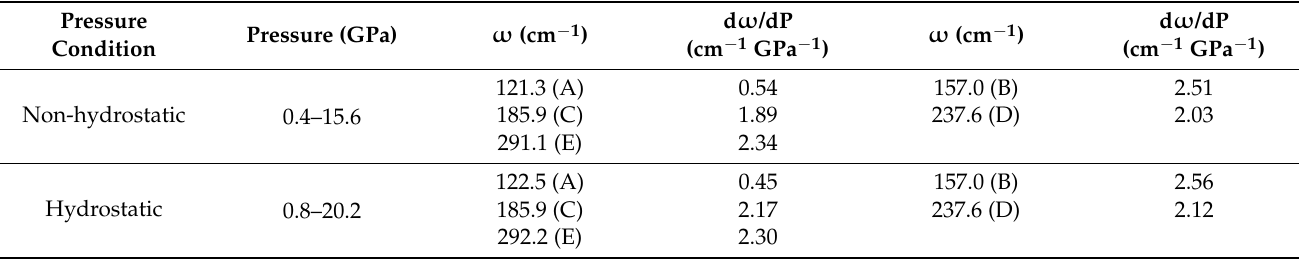
Figure 3. Pressure dependence of the Raman full width at half maximum (FWHMs) for Ga 2 Se 3 ( a , c , e ) under non-hydrostatic conditions; ( b , d , f ) under hydrostatic conditions, respectively. Here, PM represents the pressure medium. The B, D and E modes represent the Raman peaks at 157.0, 237.6 and 291.1 cm −1 obtained at 0.4 GPa under non-hydrostatic conditions and at 157.0, 237.6 and 292.2 cm −1 obtained at 0.8 GPa under hydrostatic conditions, respectively. Table 1. Pressure-dependent Raman shift (d ω /dP; cm − 1 GPa − 1 ) for Ga 2 Se 3 under non-hydrostatic and hydrostatic environments. Here, ω and P are the Raman frequency and pressure, respectively. The listed ω values are obtained at 0.4 GPa under non-hydrostatic conditions and at 0.8 GPa under hydrostatic conditions,